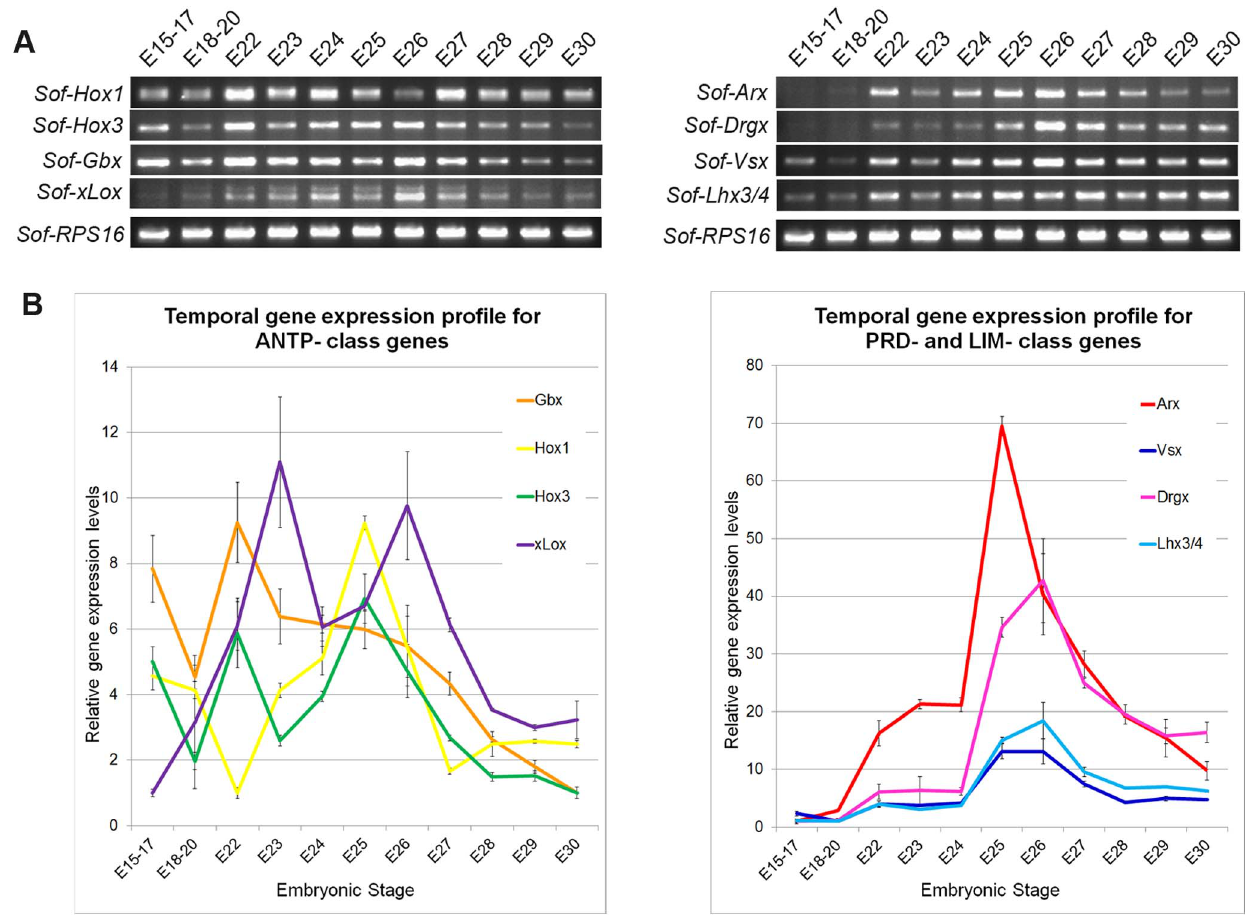
Figure 2. Temporal gene expression profiles of homeodomain genes. A) Reverse transcription polymerase chain reaction (RT-PCR) analysis of ANTP-class genes (left) and PRD- and LIM-class genes (right) amplified for 30 PRC cycles. The ribosomal protein control (Sof-RPS16) shows a saturated profile after 20 cycles, whereas all developmental transcription factors show differential peaks of expression throughout embryogenesis. B) Real time quantitative reverse transcription polymerase chain reaction (qPCR) analysis of ANTP-class genes (left) and PRD- and LIM-class genes (right). Ct data for each gene was normalized to the internal control (Sof-RPS16), and represented relative to its lowest levels of gene expression present in the assay. The ANTP-class genes show oscillating expression profiles throughout embryogenesis, whereas the PRD- and LIM-class genes show very similar expression profiles with an expression peak between stages E25–26.